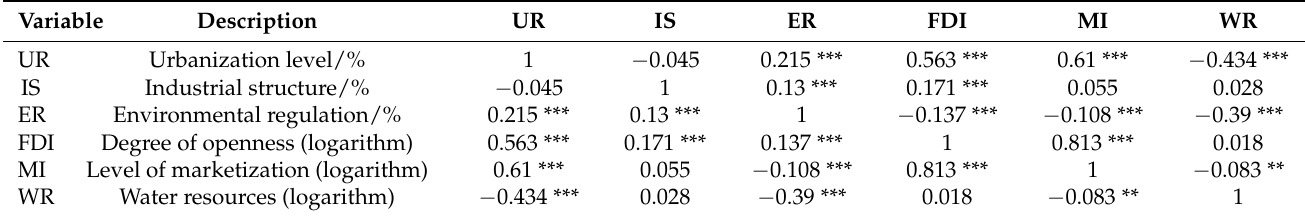
Table 2. Correlation coefficients between the